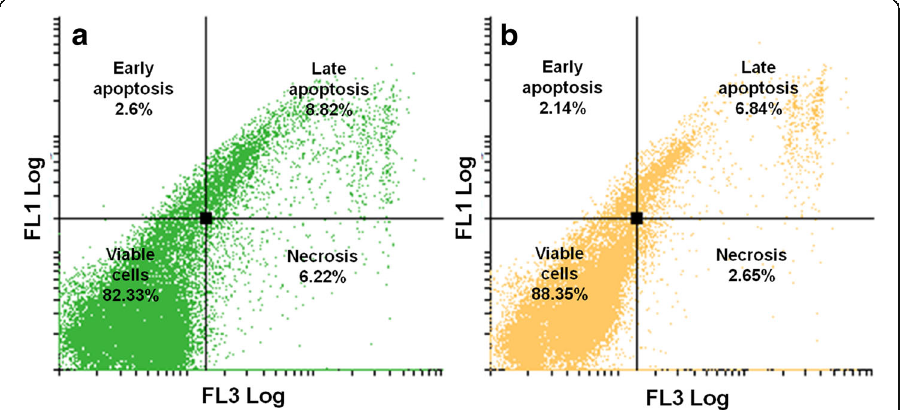
Fig. 13 Dot plots of cells indicating the occurrence of apoptosis represented as annexin V (FL1 Log) versus PI (FL3 Log). a ESE-16-treated cells: 82.33% were viable, 2.6% were in early apoptosis, 8.82% were in